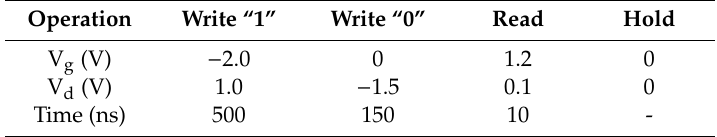
Table 2. Bias and time conditions for the transient operation of poly-Si 1T-DRAM